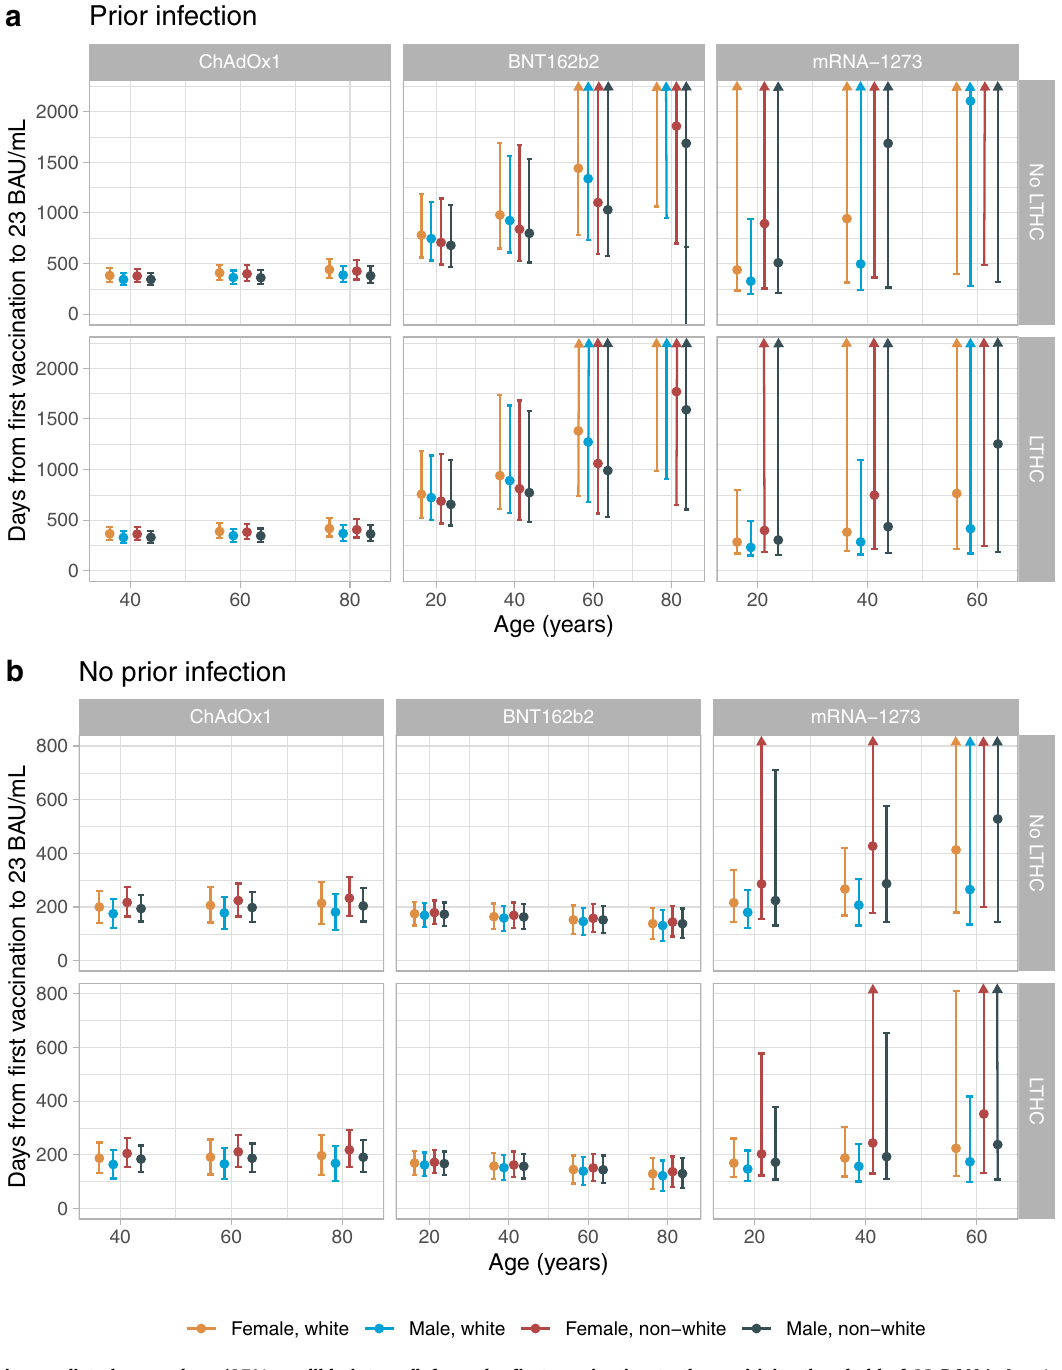
Fig. 2 Posterior predicted mean days (95% credible interval) from the fi rst vaccination to the positivity threshold of 23 BAU/mL. a In those with evidence of prior infection ( n = 7191, 5523, 414 for ChAdOx1, BNT162b2, mRNA-1273, respectively). b in those without evidence of prior infection ( n = 51,910, 30,115, 2183 for ChAdOx1, BNT162b2, mRNA-1273, respectively). Estimates were separated by age (predicted at 20, 40, 60, and 80-year-old), sex, ethnicity, long-term health condition (LTHC), and vaccine type. The y-axis is truncated at 2000 days (panel a ) for visualisation. For ChAdOx1, the 20- year-old group is not plotted because the vast majority of those receiving ChAdOx1 were ≥ 40 years. For mRNA-1273, the 80-year-old is not plotted because the vast majority of those receiving mRNA-1273 were ≤ 60 years. Equivalent estimates after second vaccination are provided in ref. 16